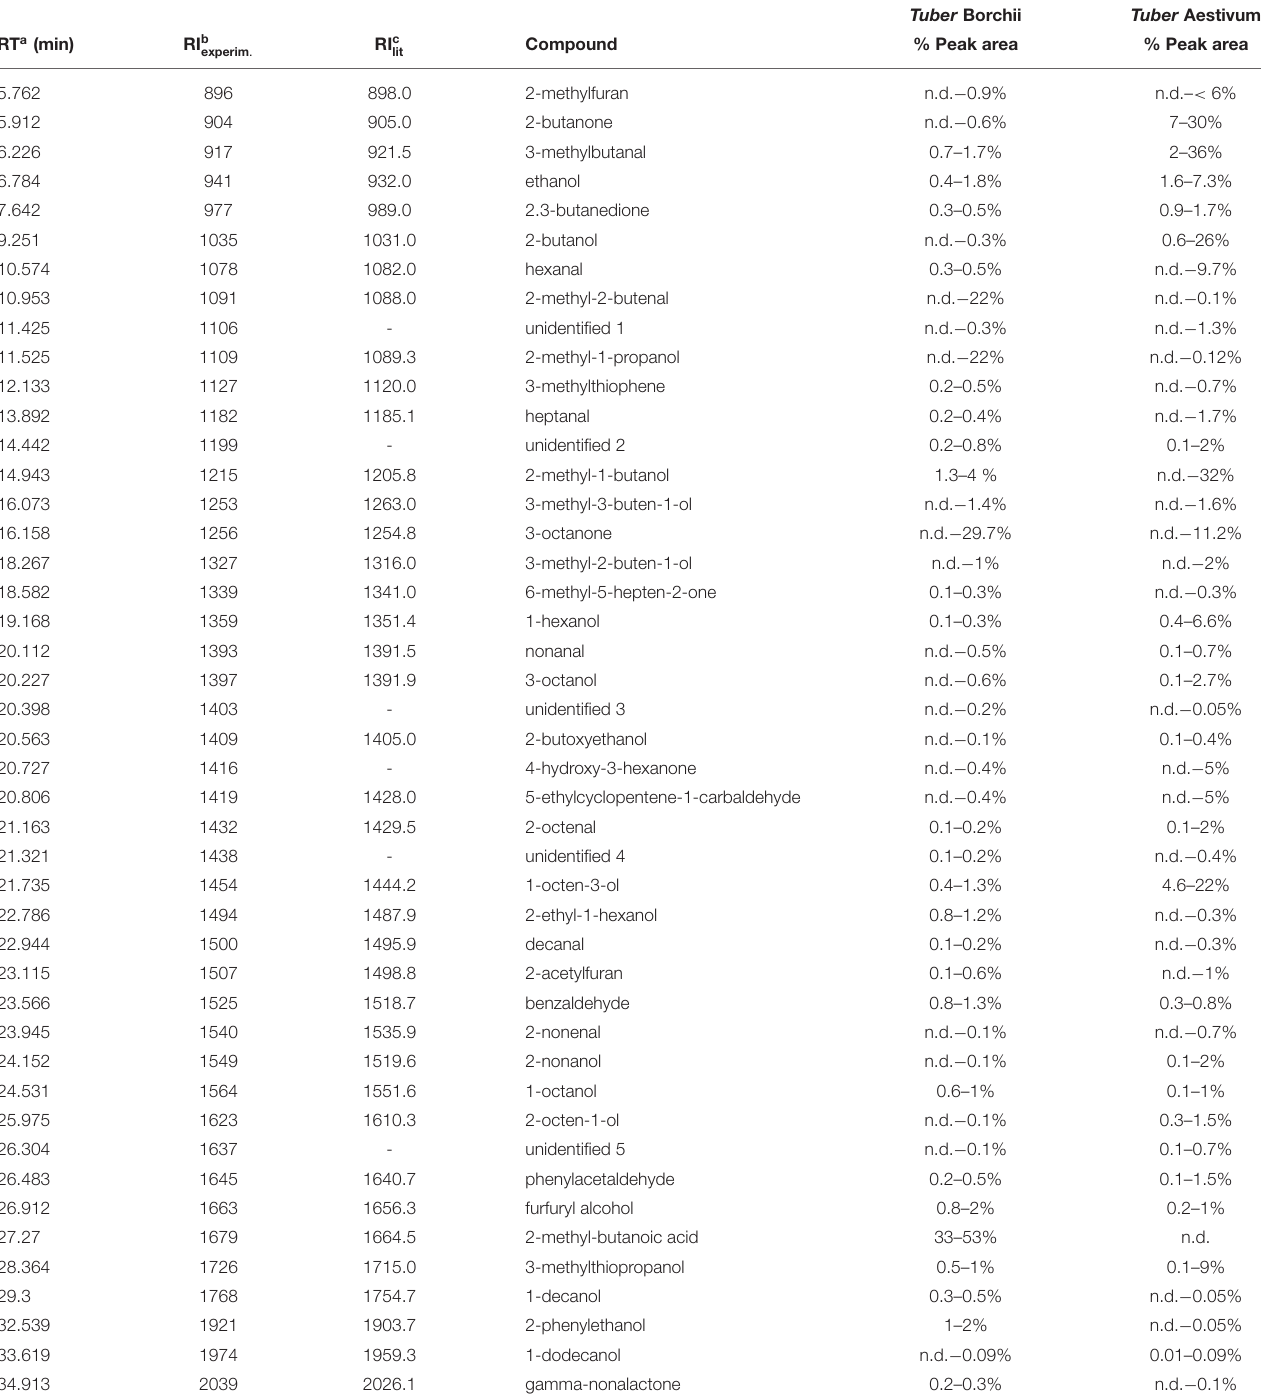
TABLE 1 | Volatile compounds identified in Tuber Borchii and Tuber